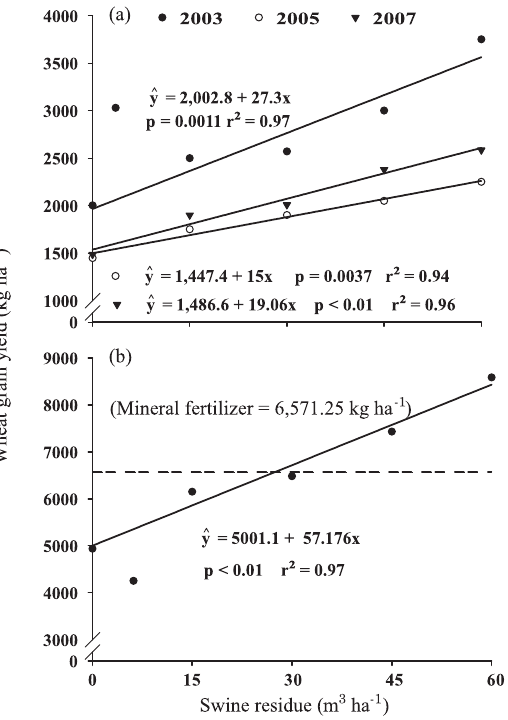
figure 3. wheat grain yield (kg ha -1 ) as related to the application of 0, 15, 30, 45, and 60 m 3 ha -1 of swine residue for the growing seasons of 2003, 2005 and 2007 (a) and wheat yield accumulated in the three harvests compared to the use of swine residue and the mineral fertilizer as recommended for wheat (b).